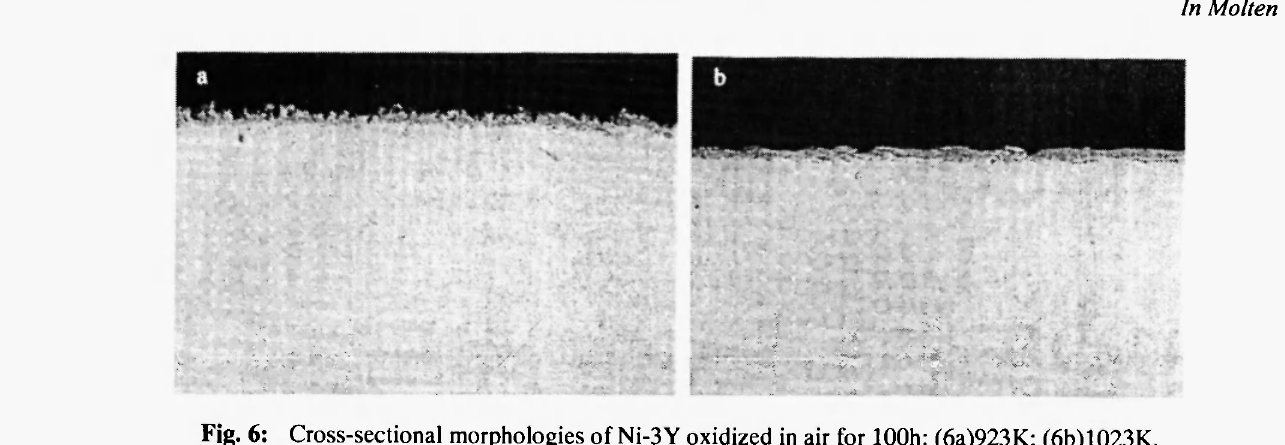
Fig. 6: Cross-sectional morphologies of Ni-3Y oxidized in air for 100h: (6a)923K; (6b)1023K.